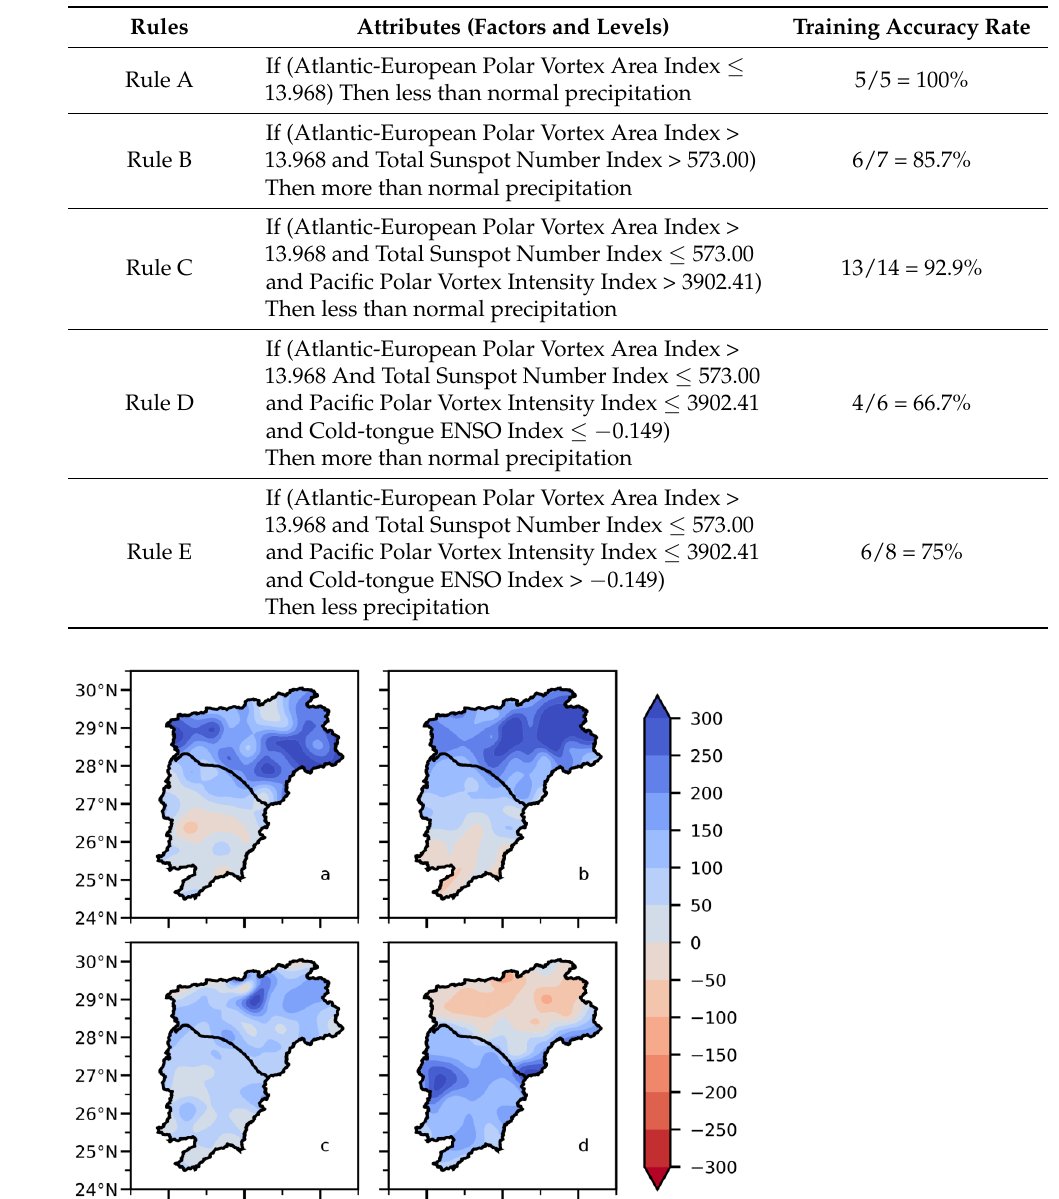
Table 3. Rule sets of summer rainfall forecast model of “Whether less (lower than 0. 5 times standard deviation)” in cluster2 of Poyang Lake basin.